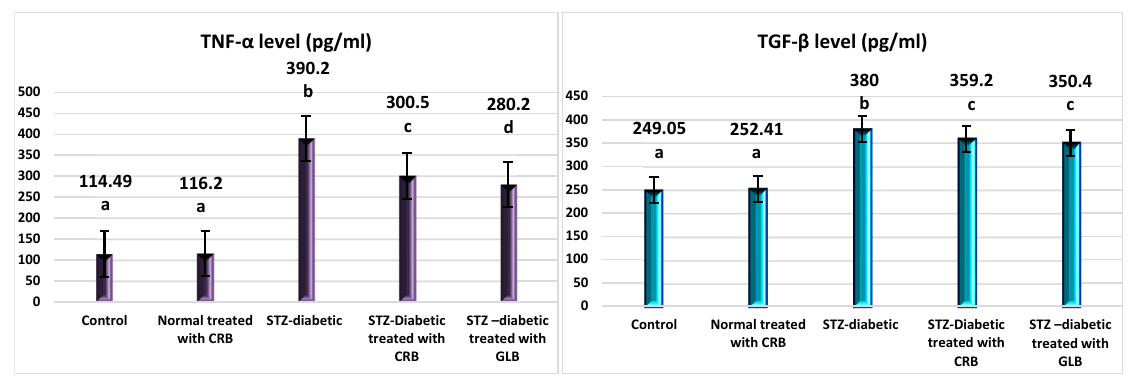
Figure 4. Cont . Plants 2022 , 11 , x FOR PEER REVIEW